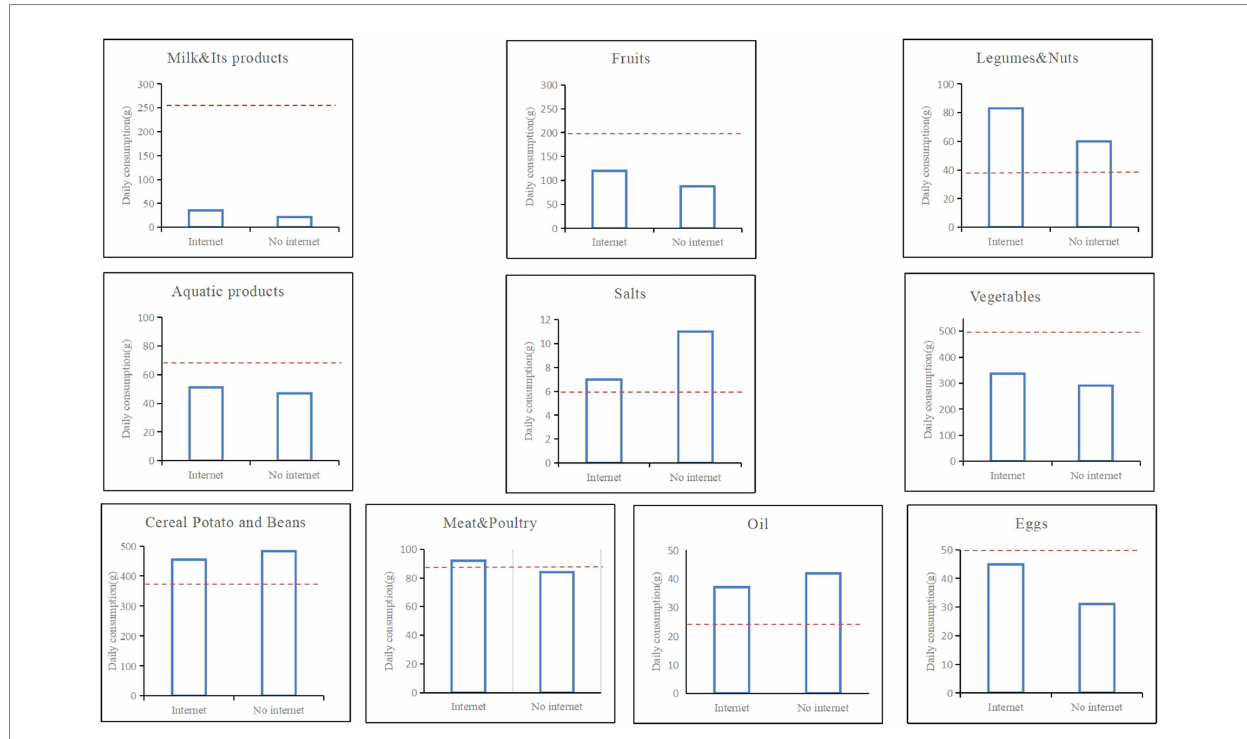
FIGURE 2 Average actual consumption of various food groups by smallholder households in China.